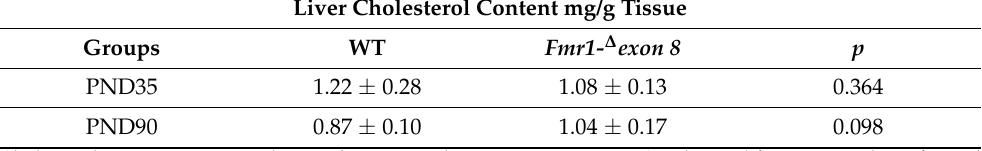
Figure 2. HMGCR and LDLR protein level in the liver of Fmr1- ∆ exon 8 and WT male adolescent (PND35) and adult (PND90) rats. ( A ) illustrates a typical Western blot (top) and the densitometric analysis of HMGCR and LDLR in PND35 rats. ( B ) illustrates a typical Western blot (top) and the densitometric analysis of HMGCR and LDLR in PND90 rats. Values represent mean ± SD obtained from 6 animals performed in duplicate. Tubulin served as a housekeeping protein to normalize protein loading. Statistical analysis was carried out by using the unpaired Student’s t -test. Table 2. Liver cholesterol content in male adolescent (PND35) and adult (PND90) Fmr1- ∆ exon 8 rats and their WT